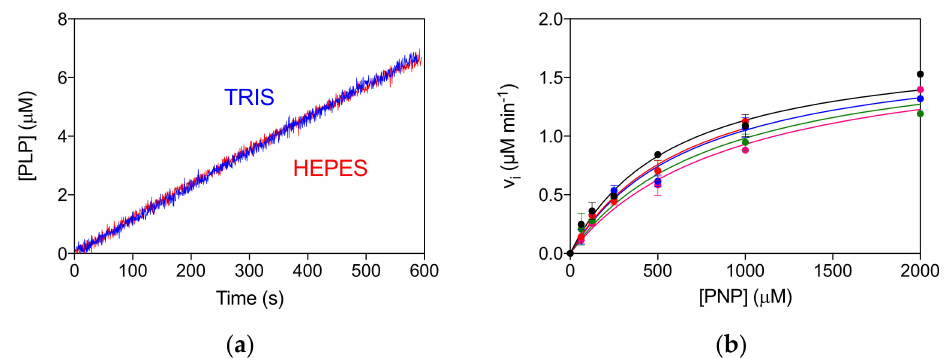
Figure 4. Lack of allosteric properties of the R161C variant. ( a ) Comparison of kinetics carried out in 50 mM Tris–HCl and 50 mM Na–HEPES buffers at pH 7.6, obtained using 2 µ M enzyme and 500 µ M PNP. ( b ) The initial velocity of the reaction was measured with 2 µ M enzyme (protein subunit concentration), varying PNP concentration while keeping exogenous PLP fixed at different concentrations (0, 0.5, 1, 2, and 4 µ M). Data are the average ± standard deviation of three independent measurements. The resulting saturation curves were fitted to the Michaelis–Menten equation, obtaining very similar apparent V max and K M values at all PLP